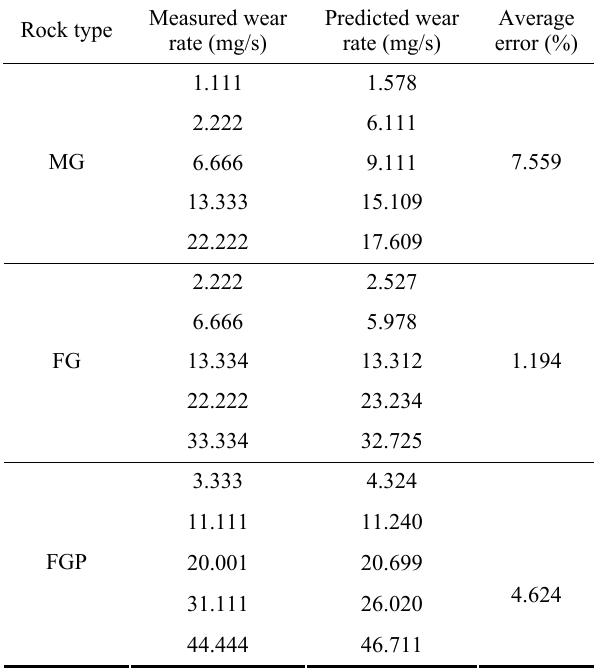
Table 7 Measured and predicted wear rate of the WC drill bit for different types of rock